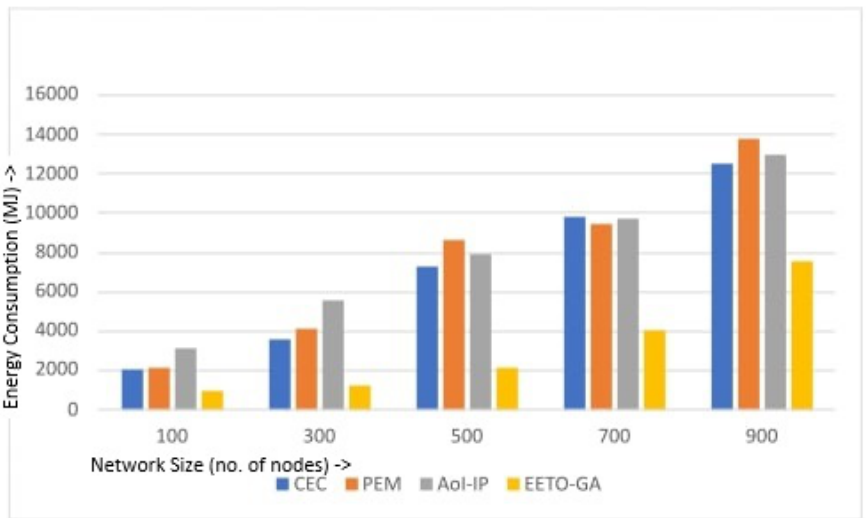
Figure 4. IoT Device Energy Consumed (IoTDEC) in EETO-GA and Other